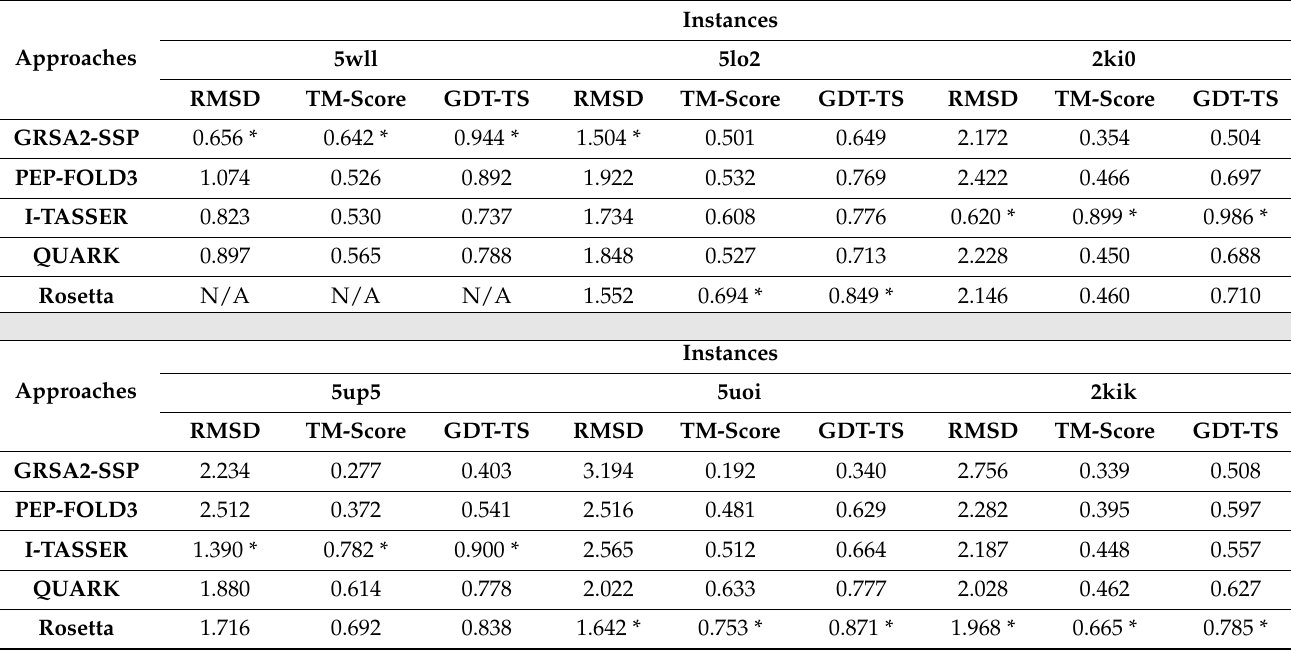
Table 4. Average metrics results of